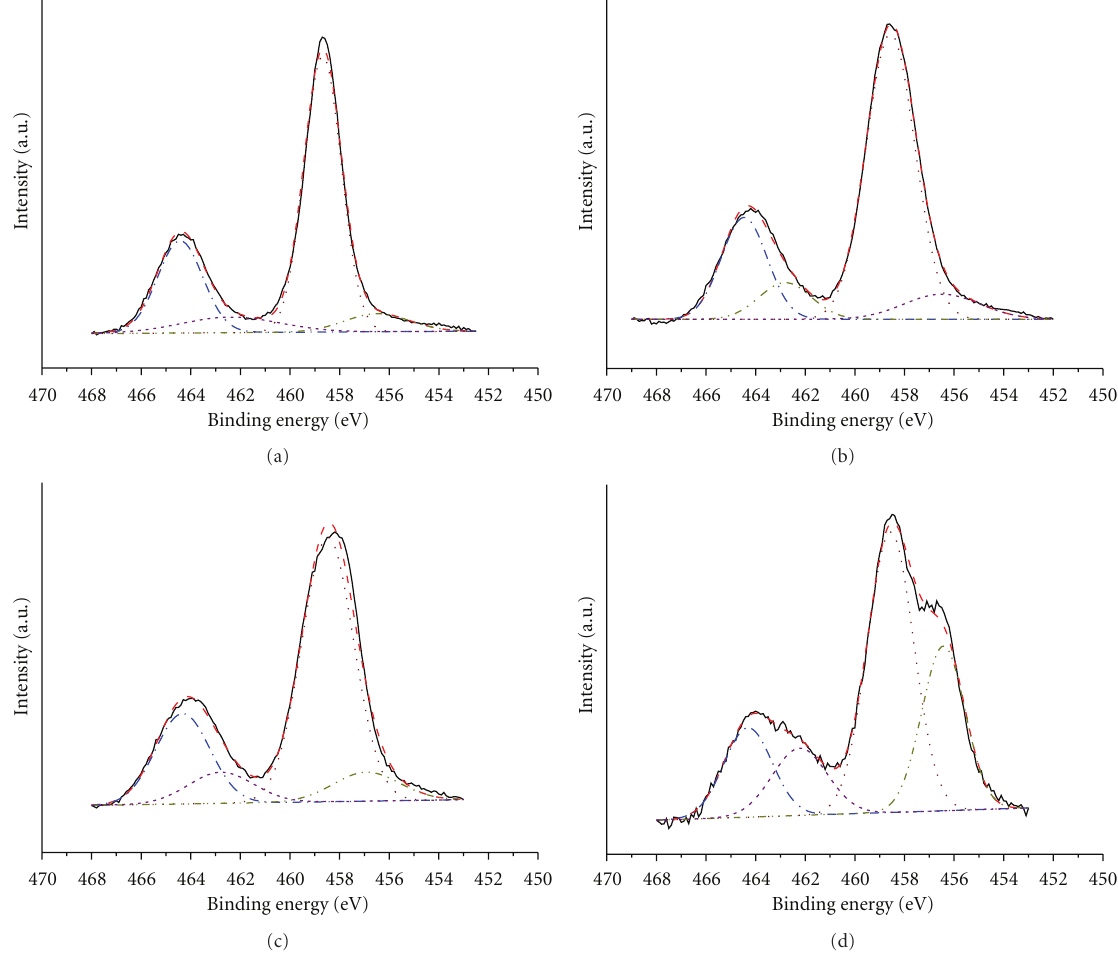
Figure 5: Ti 2 p XPS spectra of TiO 2 synthesized at Al 2 O 3 /Ti mass ratio of (a) 0, (b) 0.1, (c) 0.3, and (d) 0.5.